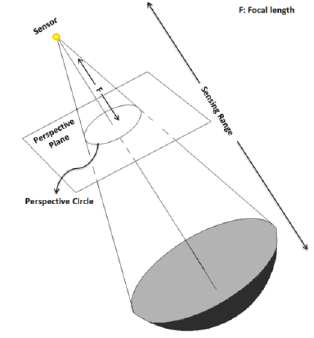
Figure 3. Perspective plane and